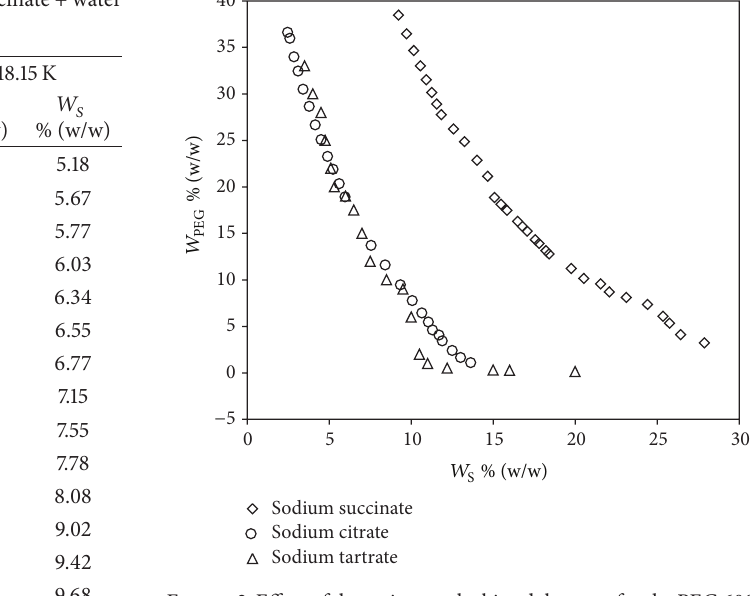
Figure2:EffectofthecationonthebinodalcurvesforthePEG6000 ) + salt ( 𝑊 ) + water systems at 298.15 ( 𝑊 PEG S